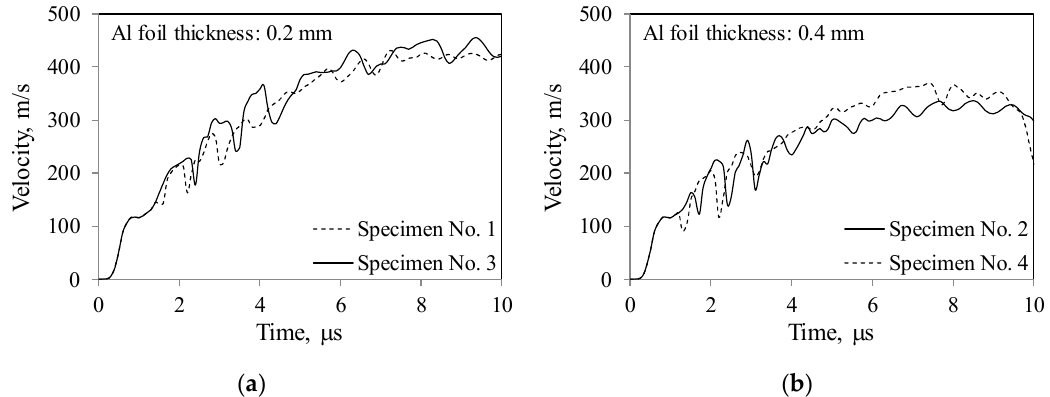
Figure 4. Velocity variation of the outer aluminium pipe during explosive compaction: ( a ) foil thickness 0.2 mm and ( b ) foil thickness 0.4 mm.